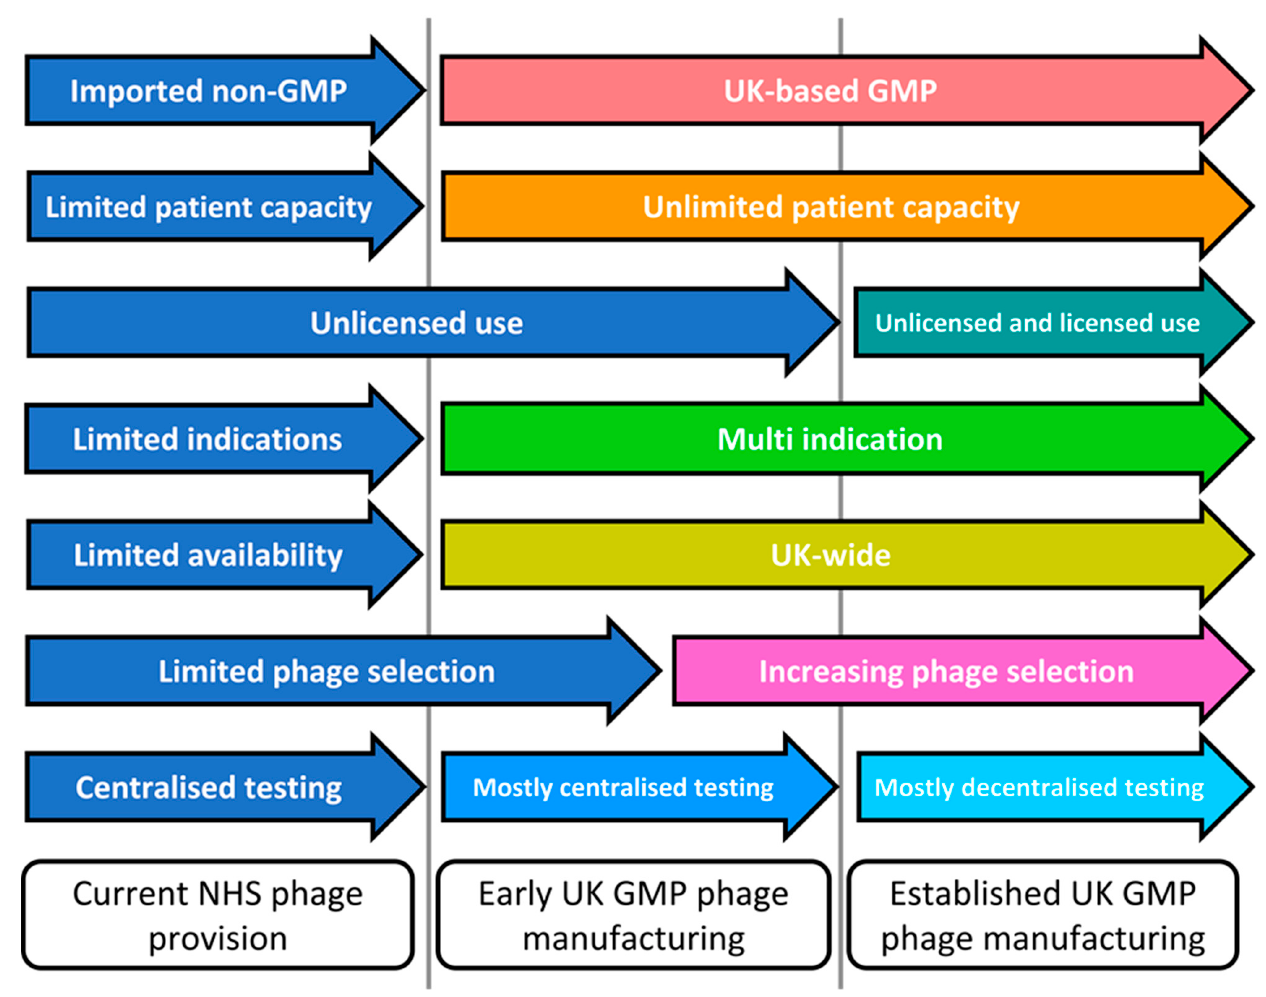
Figure 2. The current and future stages of UK phage therapy infrastructure.